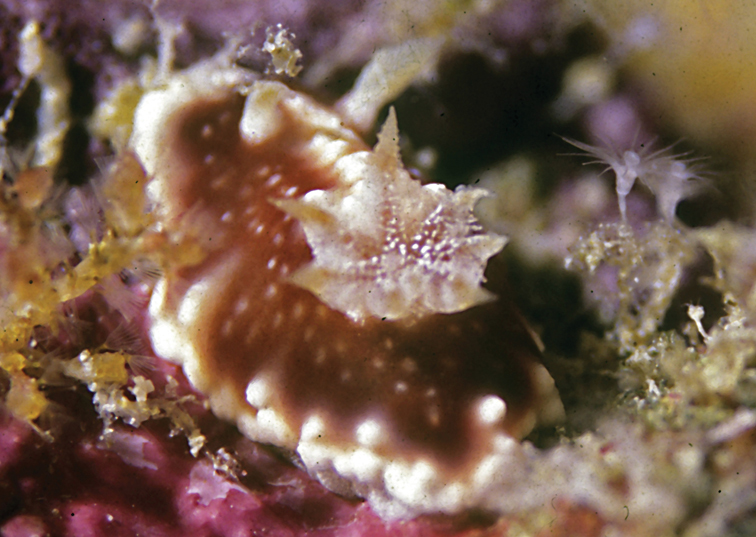
Chromodoris geometrica, 15 mm, Maldives, RC Anderson.